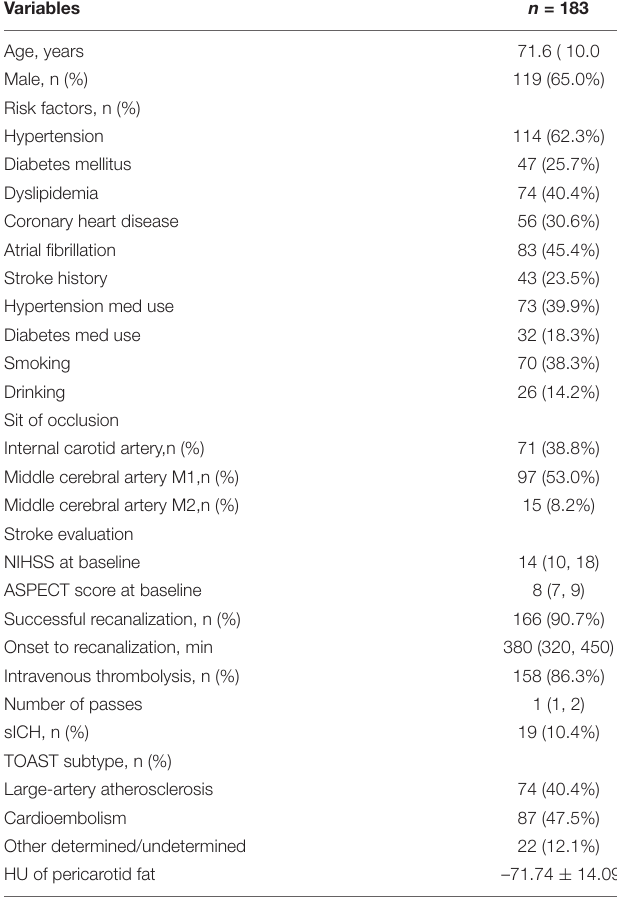
TABLE 1 | Characteristics of acute stroke patients treated with mechanical